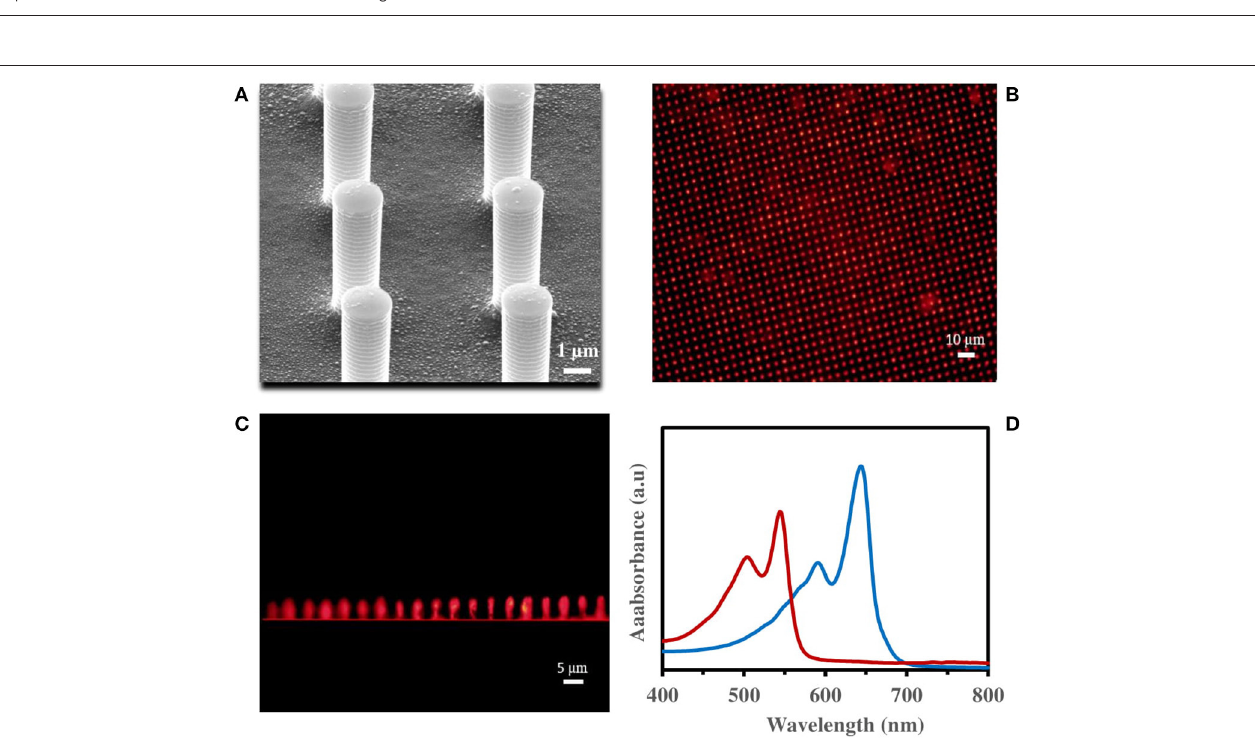
FIGURE 3 | (A) SEM images of immobilized PDA vesicles on PDMS micropillars, fluorescence microscopic image of PDA immobilized on PDMS micropillars from (B) top view, (C) side view, (D) visible spectra of immobilized PDA vesicles on quartz substrate, before (blue line) and after (red line) 1h incubation in 0.1mM surfactin.